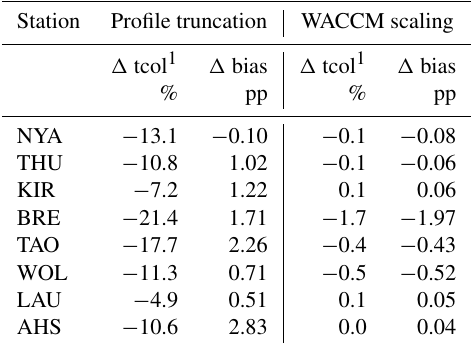
Table C2. Difference between original profile validation and truncation or profile filling techniques (V6 TIR–NIR).